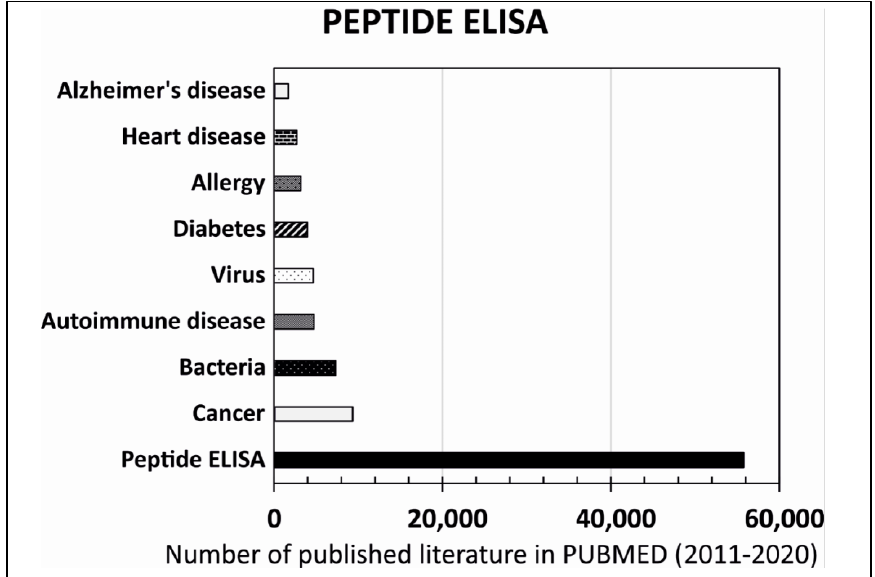
Figure 4. Understanding the role of peptides in ELISA in diagnostics through the published literature on PUBMED in the last decade (1 January 2011 to 31 December 2020). Comparison of the data published with the keyword peptide ELISA along with additional filters for Alzheimer’s disease, Heart disease, Allergy, Diabetes, Virus, Autoimmune Disease, Bacteria, and Cancer, respectively. We observed Cancer was ranked 1 st for peptide ELISA.